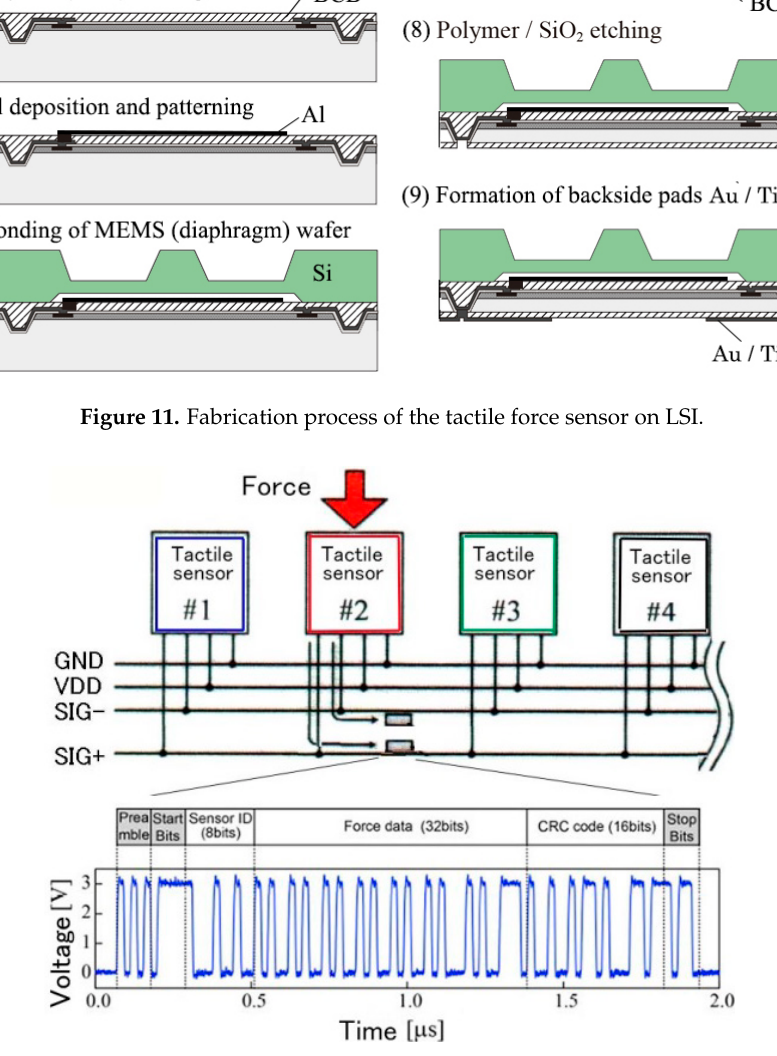
Figure 12. Packet communication for the tactile sensor network.